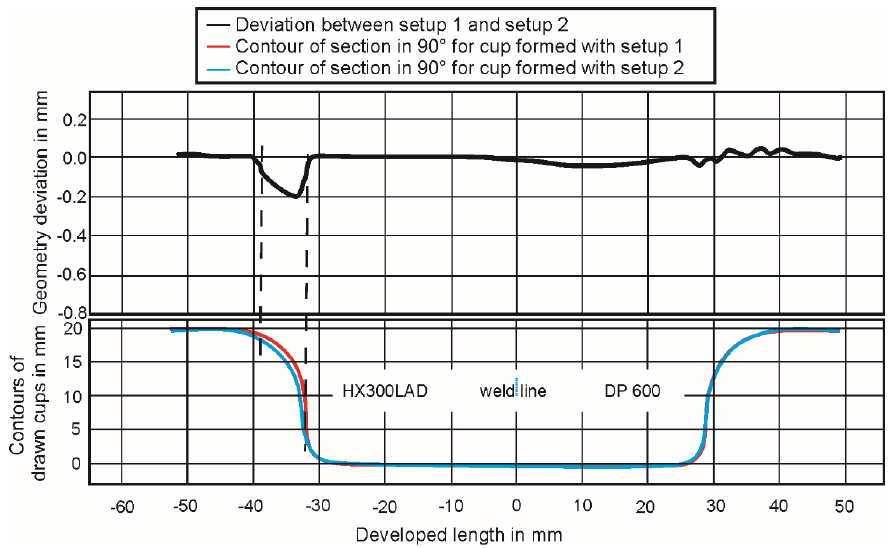
Figure 6. Geometry deviation due to the use of elastic dies.